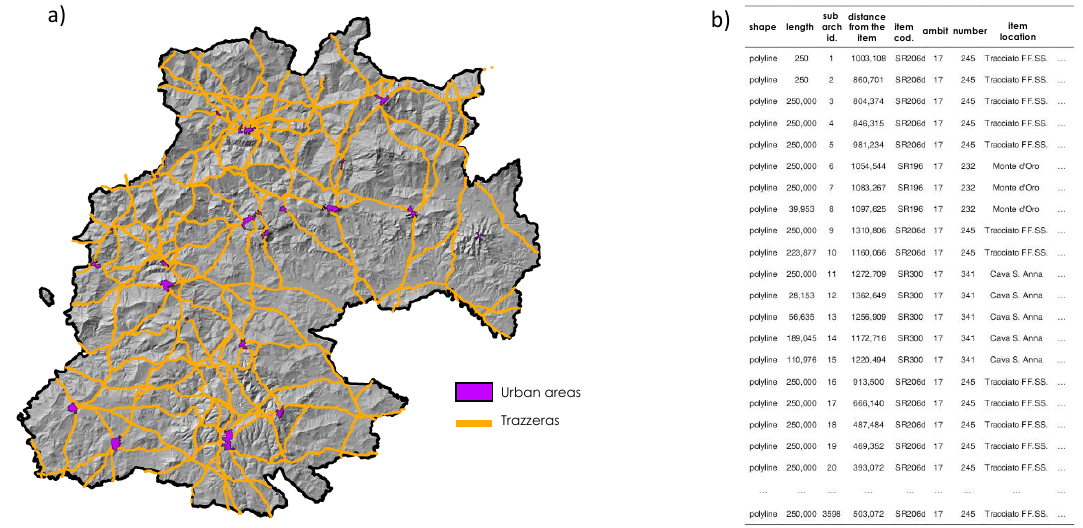
Figure 9. ( a ) Map of the TRP in Enna Province; ( b ) excerpt of the database of the ICT-GIS tool. The following fi gures synthesize the assessment process of the paths making up the Enna Province TRP based on the detailed information units referred to as the four values of the above-mentioned quadrangular axiological pa tt ern.